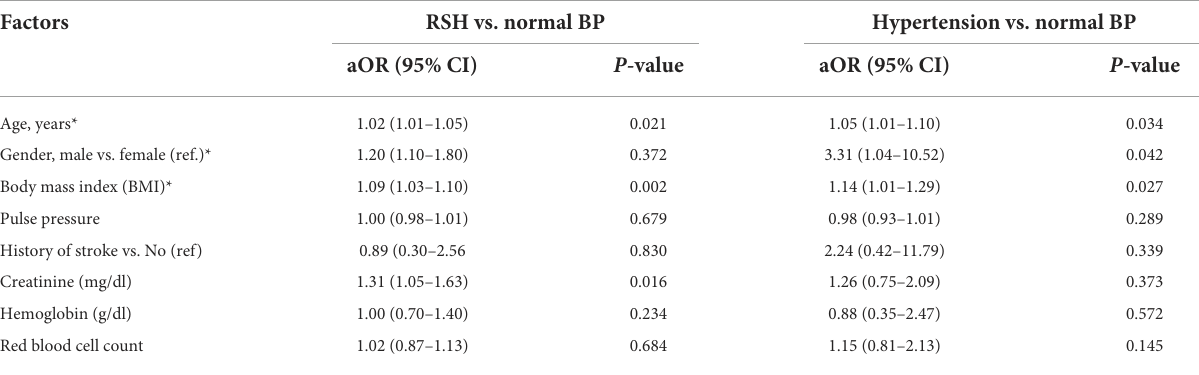
TABLE 3 Multivariate multinomial logistic regression analyses of factors associated with RSV and hypertension among SCD patients in Cameroon (reference: Normal BP). Factors RSH vs. normal BP Hypertension vs. normal